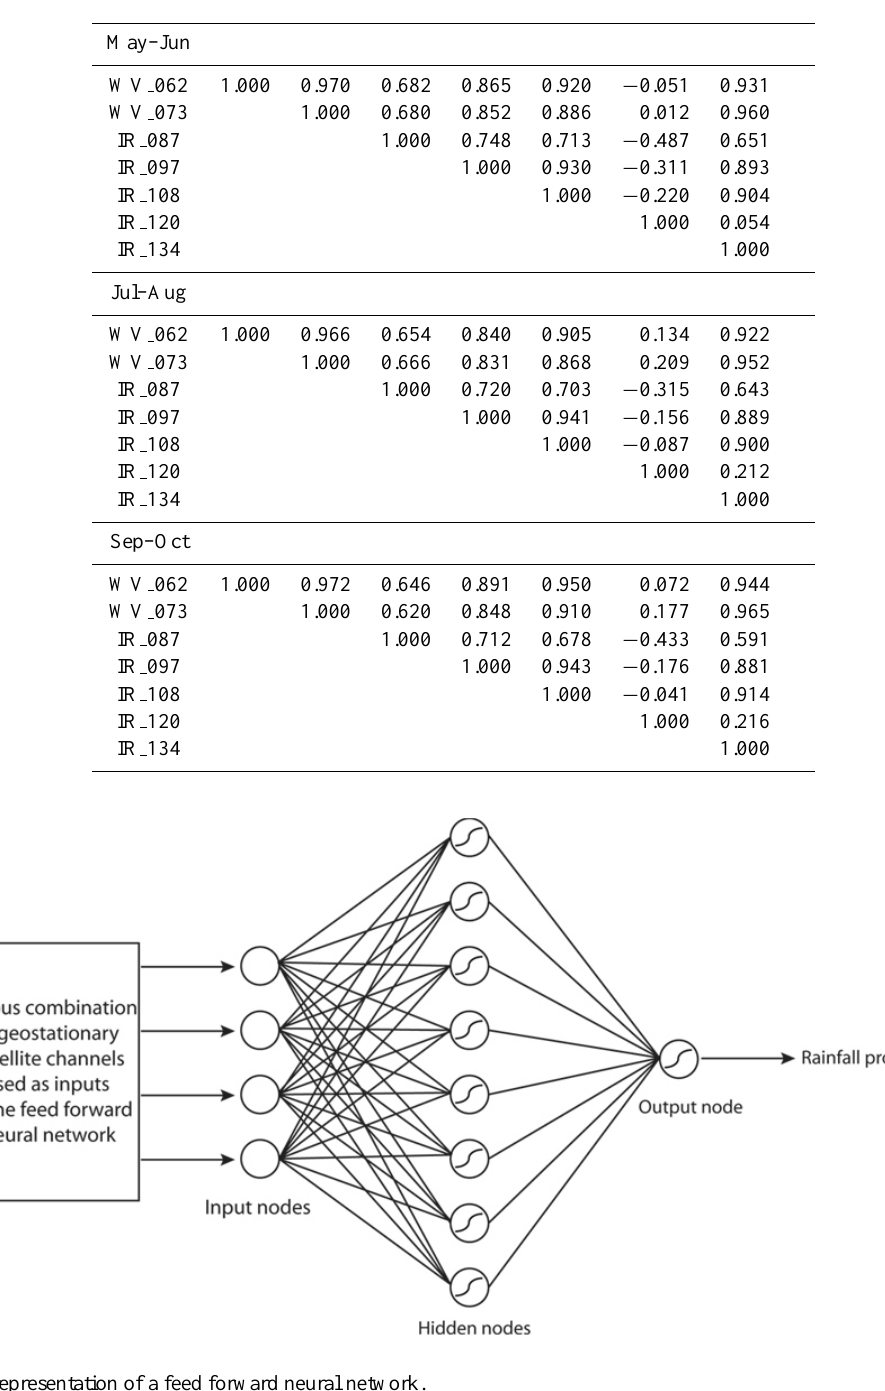
Figure 4. Schematic representation of a feed forward neural network